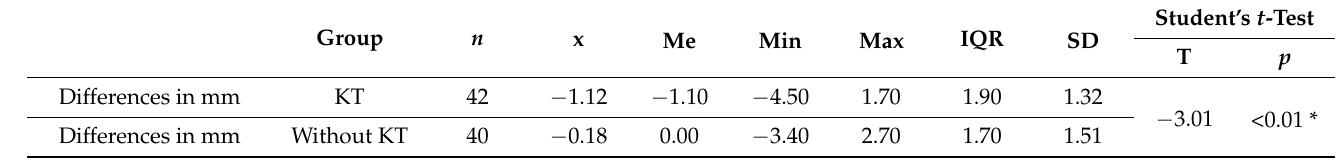
Table 2. Differences [mm] in linear measurement taken above fibula head at the highest point.